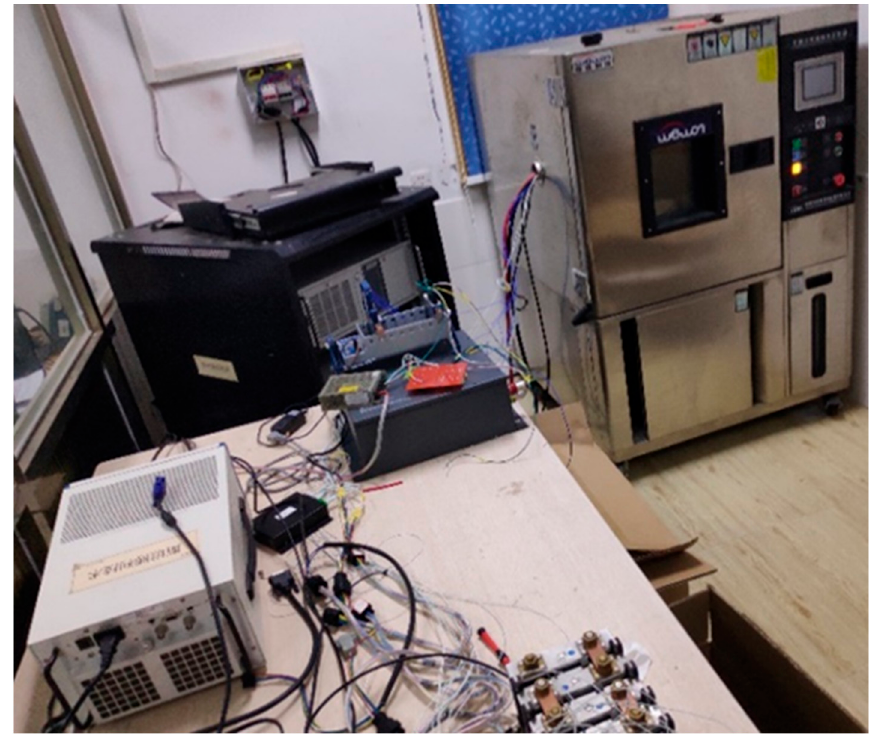
Figure 4. Photos of battery characteristic test platform.